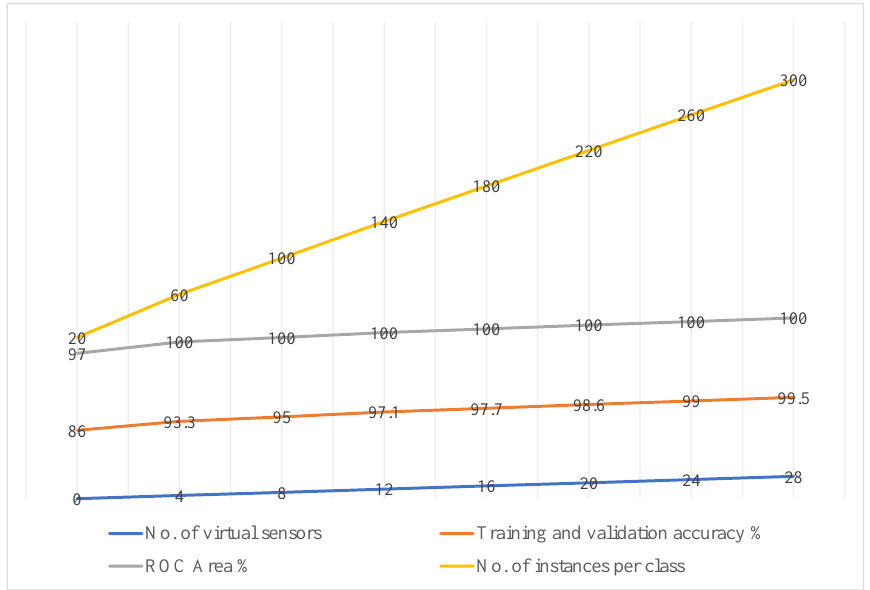
Figure 16. Different numbers of virtual sensors and their effect on the classification performance and